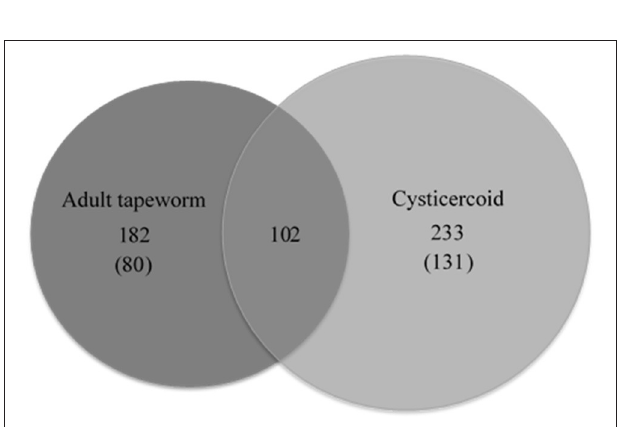
FIGURE 2 | The number of proteins and common proteins identified for cysticercoid and adult tapeworm H . diminuta . The number of proteins identified only in either the cysticercoid or adult stage is given in